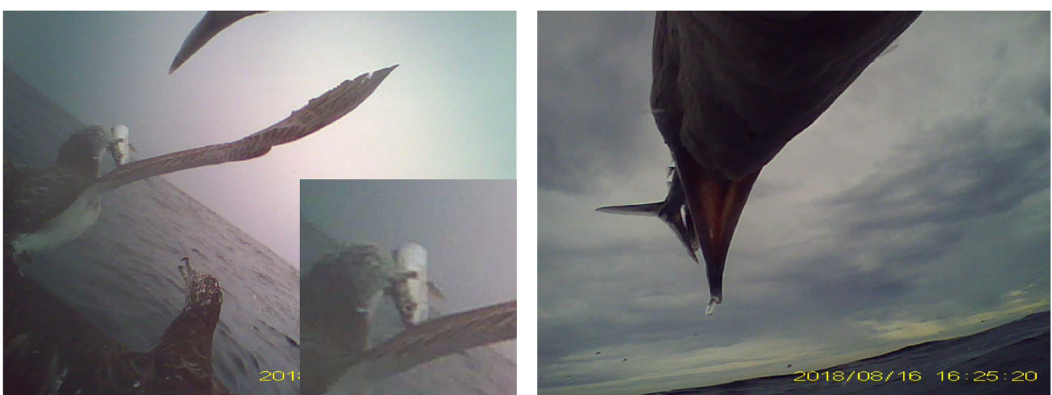
Fig 4. Screenshots of prey captures. A number of prey captures were observed in the DVL recordings. These examples show an unknown species capture by a conspecific which is then competed for by other shearwaters following take-off (left), and a Pacific saury caught by the tagged individual during a surface seizing event (right). This footage suggests that shearwaters capture prey then feed whilst in flight.